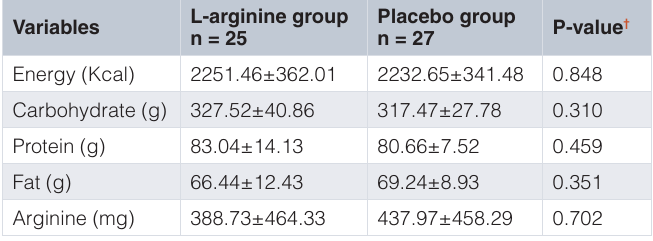
Data is presented as mean and standard deviation † Obtained from independent sample t